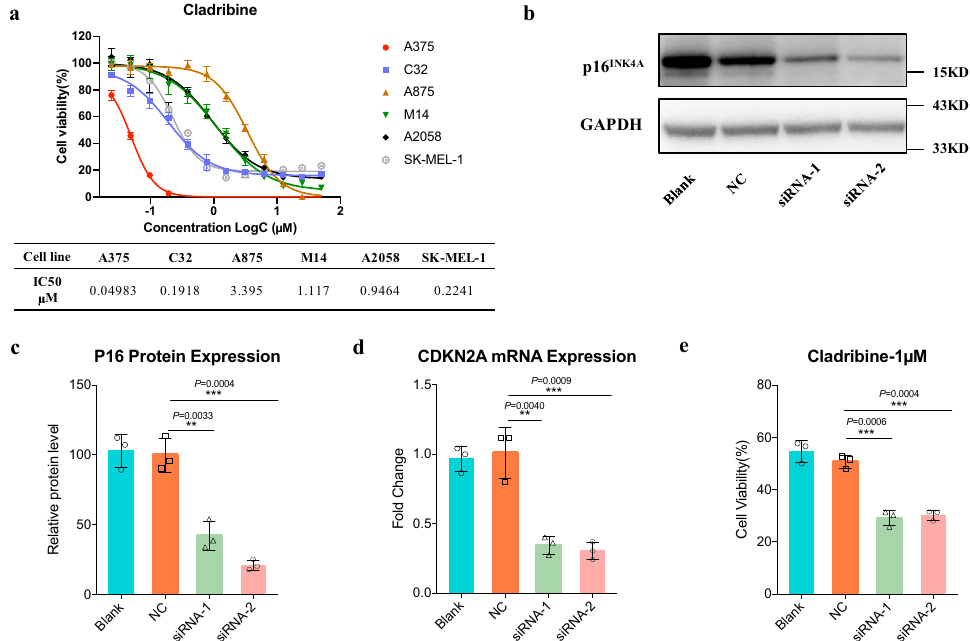
Fig. 6 An in-vitro validation of cladribine treatment for melanoma cell lines with CDKN2A LOF mutations. a CDKN2A LOF mutations in melanoma cell lines were correlated with sensitivity to RRM2 inhibitors. Melanoma cell lines ( n = 6) were incubated with 12 different concentrations of RRM2 inhibitor cladribine and the IC50 values of cladribine were calculated (Data are means±SD of the mean from three independent experiments). b , c CDKN2A silencing by siRNA in CDNK2A WT cell A2058 and P16INK4A protein was measured by western blotting analysis ( n = 3 biologically independent experiments, repeated at least 3 times independently with similar results; Mean±SD shown; ** p <0.01, *** p <0.001, two-tailed unpaired t test). d Relative mRNA expression was determined at 48h post-transfection of CDKN2A siRNAs by RT-qPCR analysis ( n = 3 biologically independent experiments; Mean±SD shown; ** p <0.01, *** p <0.001, two-tailed unpaired t test). e CDKN2A LOF A2058 cells and corresponding control cell were treated with 1 μ M cladribine measured in a 3-day